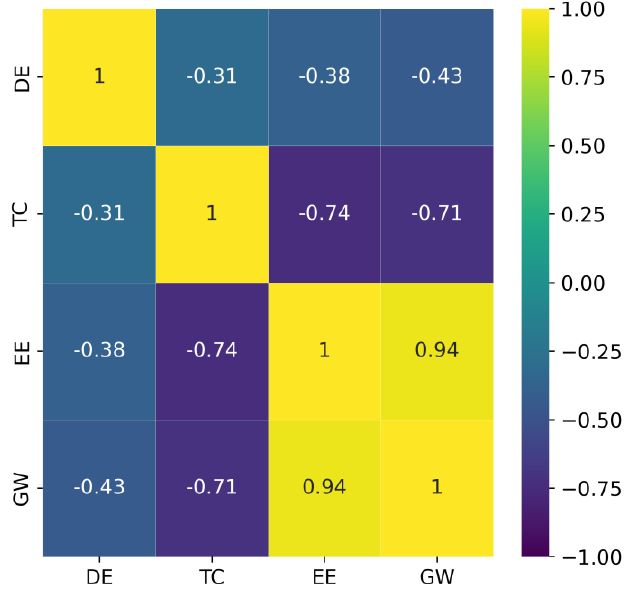
Figure 3. Correlation of features with a heat map.